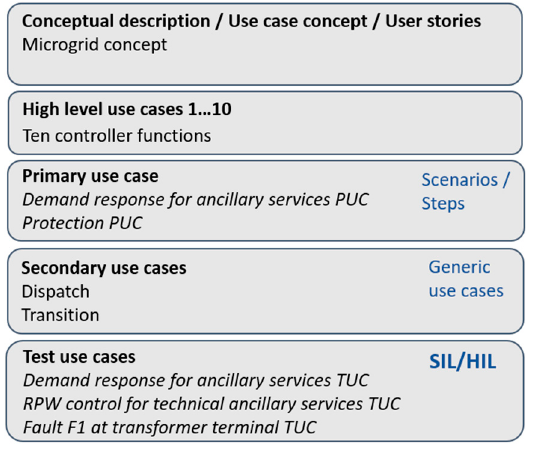
Figure 7. The applied use cases.